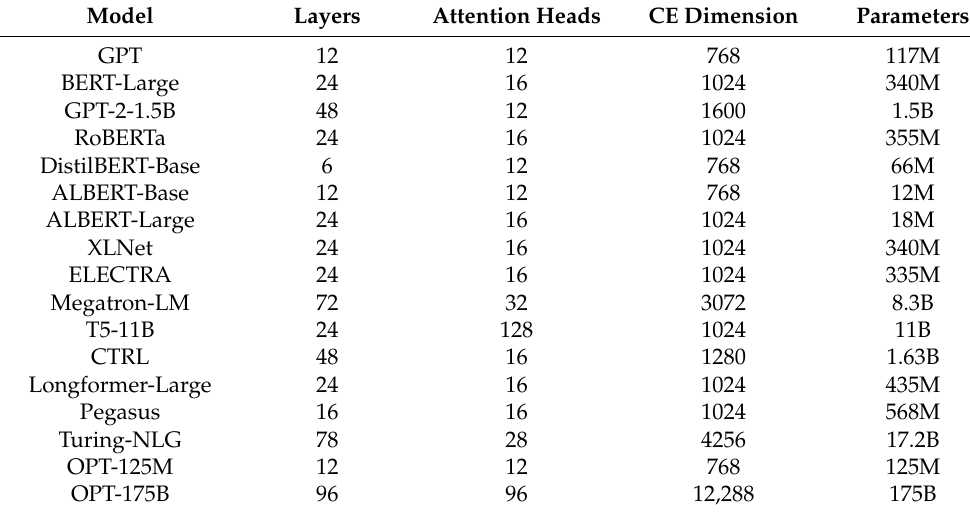
Table 1. Model architecture details in terms of number of layers, number of attention heads, dimension of contextual embedding and trained parameters.